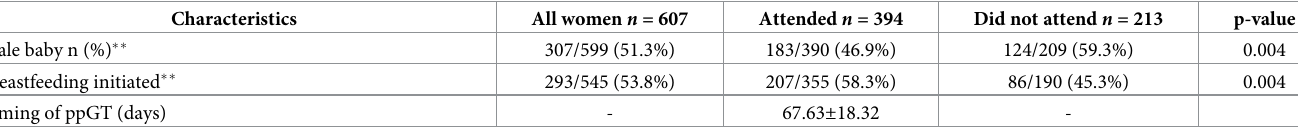
GDM women for ppGT (Fig 3). Our proposed ML prediction model has the highest benefit across various probability thresholds and specifically identified 46% GDM women who are unlikely to attend ppGT (optimal threshold = 0.464). Based on our proposed final model, the composite risk score, P (non-attendance to ppGT), was calculated as 1/[1+exp( −b )], where b = − 3.1599 + (0.1926 × antenatal fasting glucose) + ( − 0.1415 × antenatal postprandial